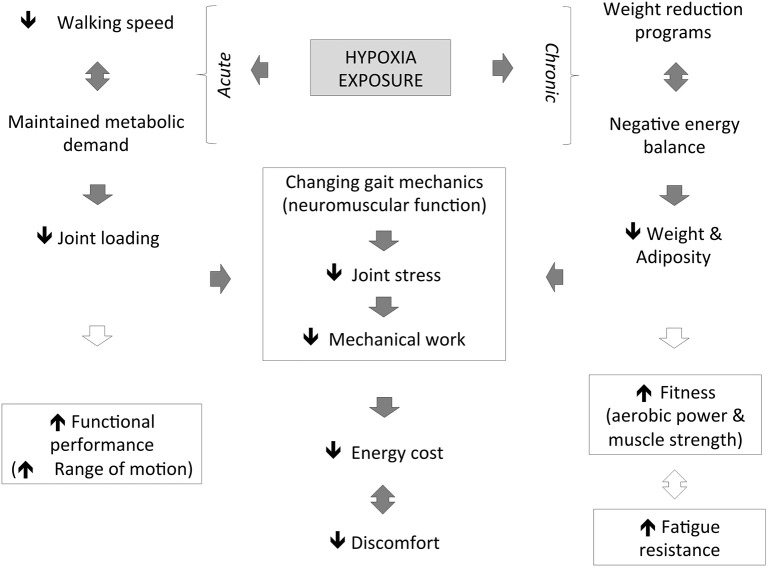
Illustration of the hypothetical effects of hypoxia exposure on neuro-mechanical constraints associated with walking in obese patients.